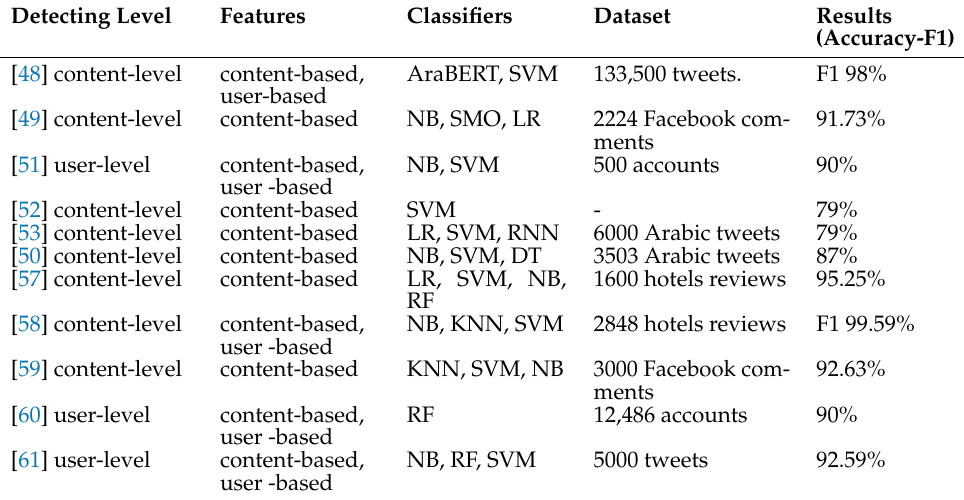
Table 1. Arabic spam detection